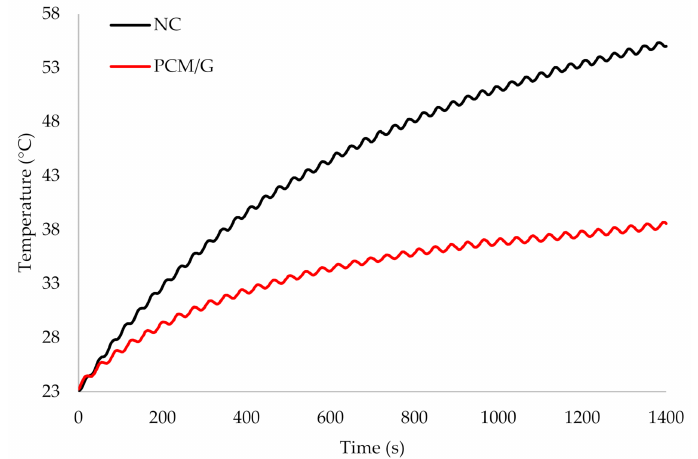
Figure 5. Temperature evolution of the LiC cell under 150 A current rate when the PCM/graphite (PCM/G) is used as the cooling system. Natural convection (NC) is shown for